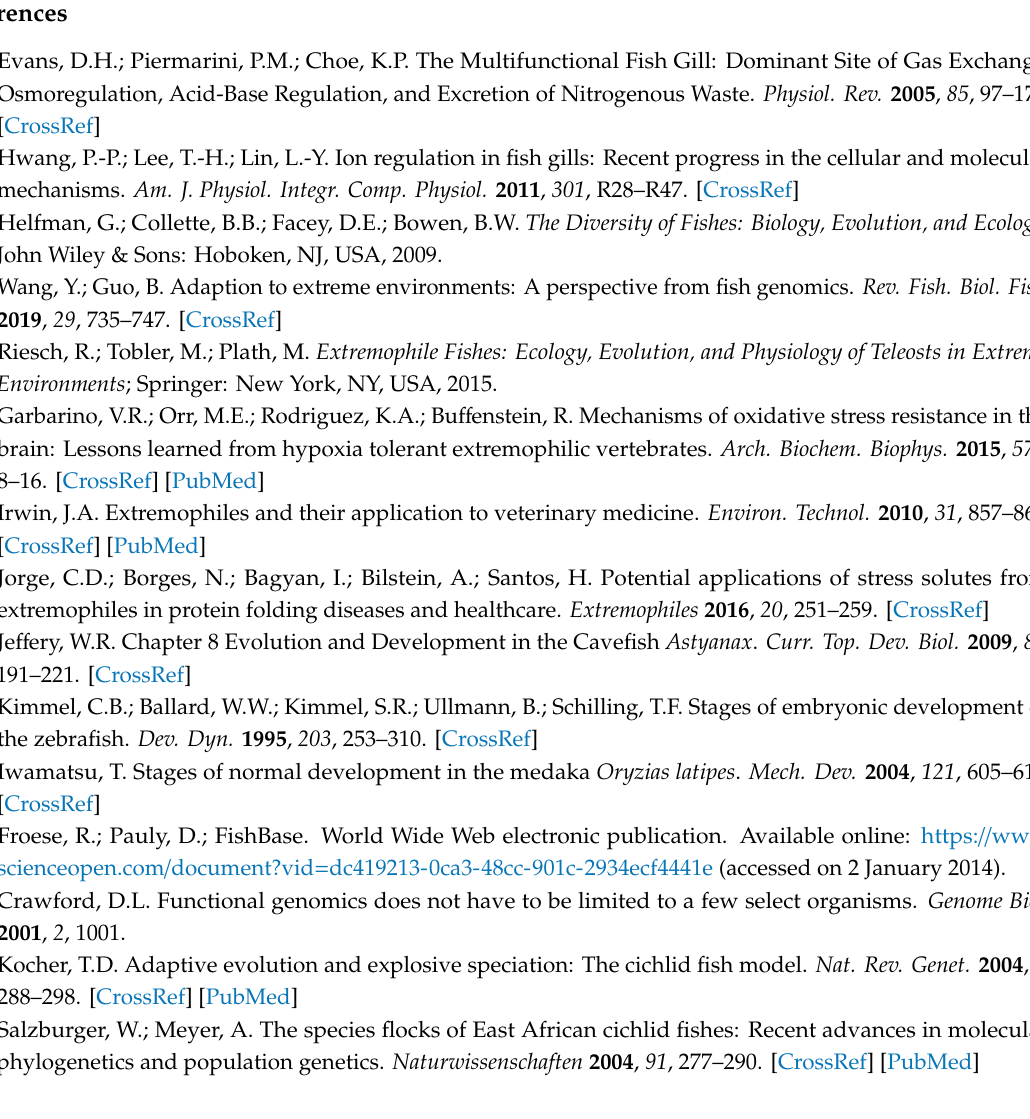
Figure S1. Expression of cardiac regulator gata4 in zebrafish; Figure S2. Expression of cardiac regulator tbx5b in zebrafish; Figure S3. Expression of cardiac regulator mef2ca in zebrafish; Movies: Contracting heart during O. alcalica